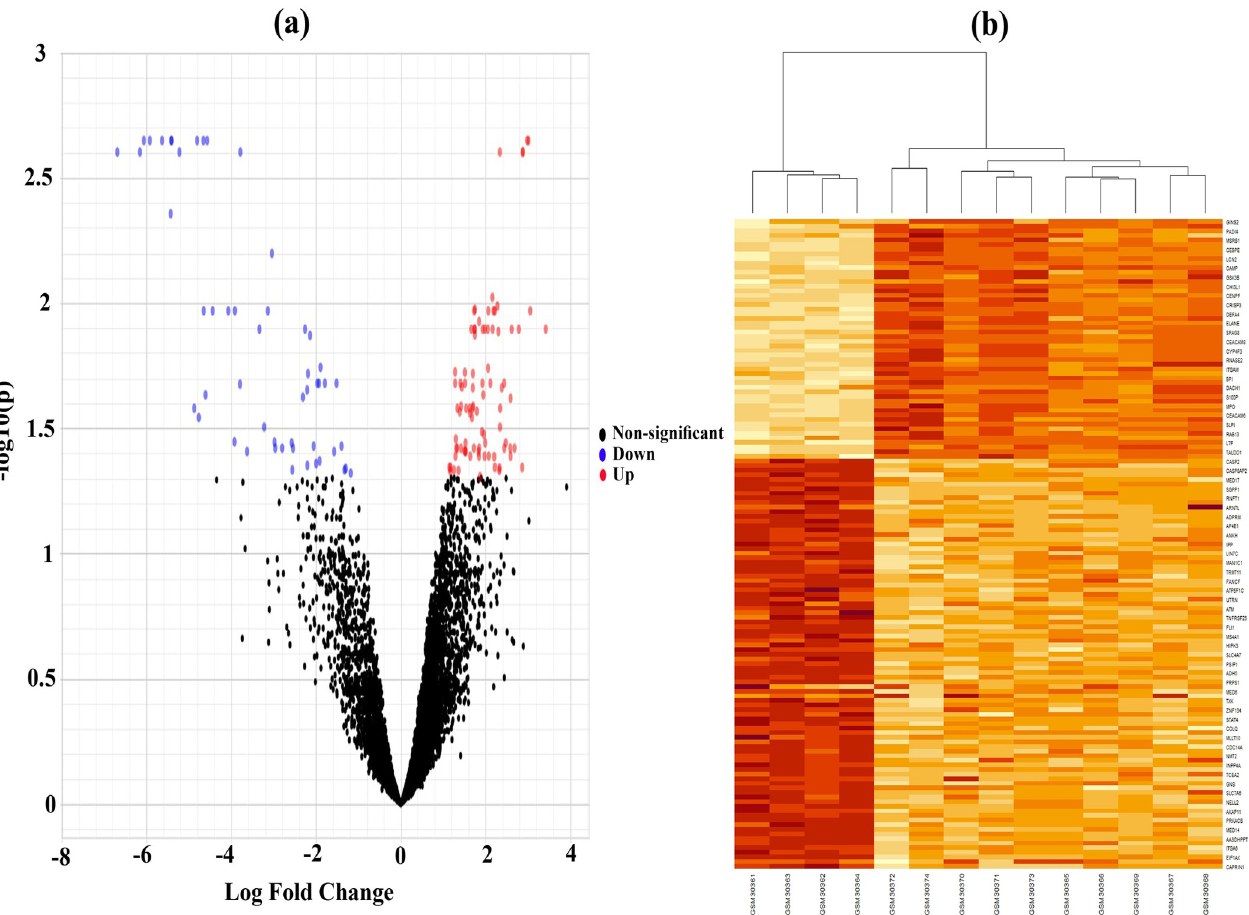
Fig 2. (a) Volcano plot of microarray data highlighting DEGs (blue: down regulated; red: up regulated; and black: insignificant), (b) Hierarchical clustering of DEGs to visualize up-regulated and down-regulated genes.